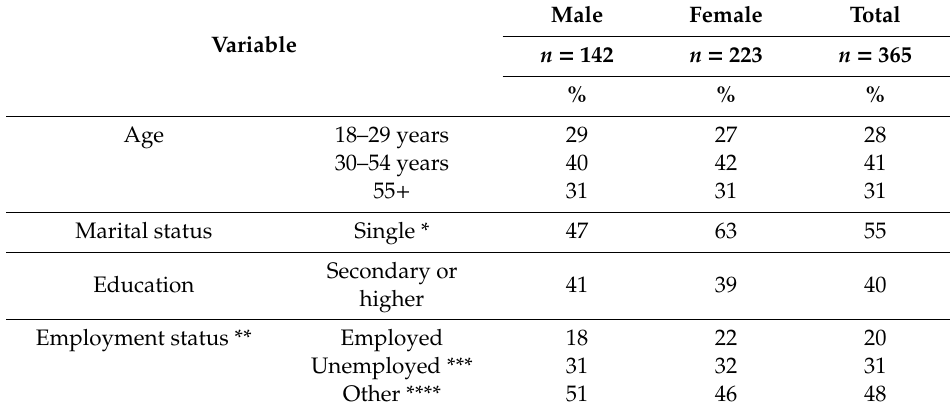
Table 1. The descriptive statistics of the study population, %, n